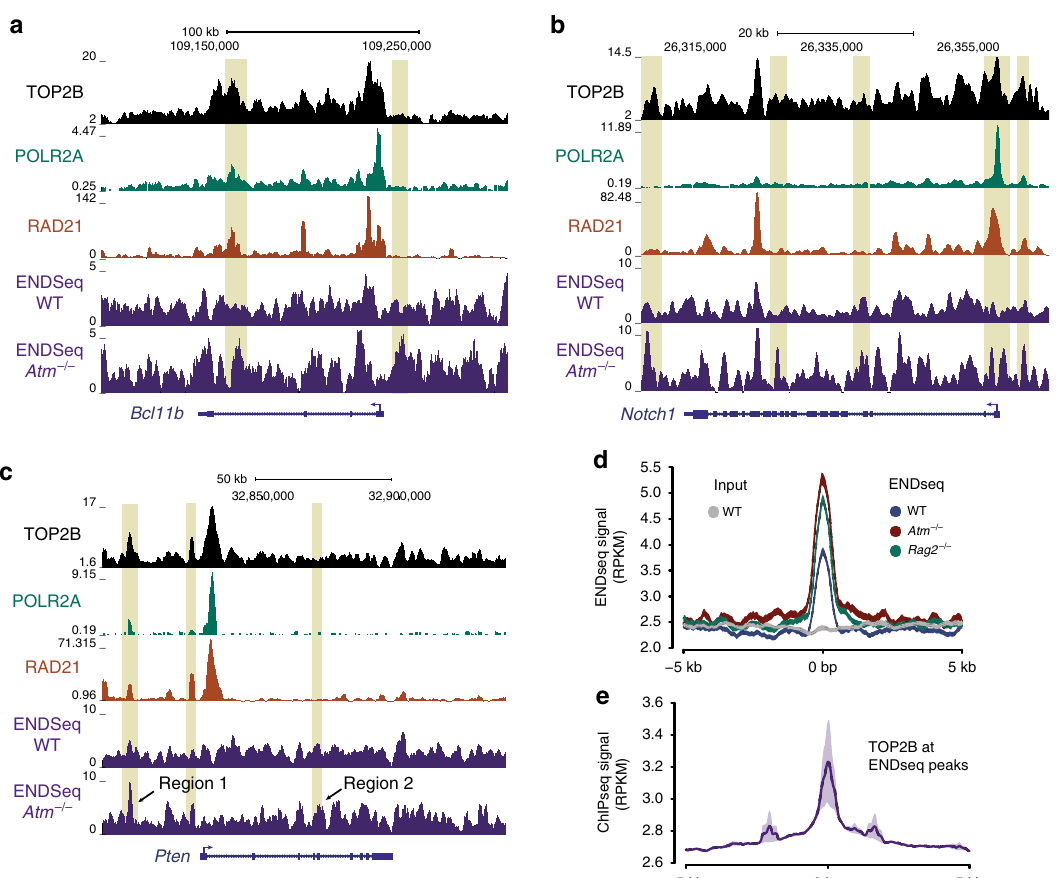
Fig. 5 TOP2B colocalizes with endogenous DSB accumulation in thymocytes. a – c Genome browser view of TOP2B, POLR2A, RAD21, and ENDseq (DSBs) signal tracks in wild-type and Atm − / − primary thymocytes, as indicated, at Bcl11b ( a ), Notch1 ( b ) and Pten ( c ) loci. Atm − / − -speci fi c ENDseq peaks, de fi ned as those not called in wild-type thymocytes, are highlighted in yellow. Two regions of interest in Pten are indicated as region 1 and region 2. d Global pro fi le of ENDseq signal at TOP2B peaks in wild-type, Atm − / − and Rag2 − / − primary thymocytes. Control input signal is also shown. e Global pro fi le of TOP2B signal at ENDseq peaks in wild-type primary thymocytes. Set of ENDseq peaks were determined as the merge between those detected in any of the analysed genetic